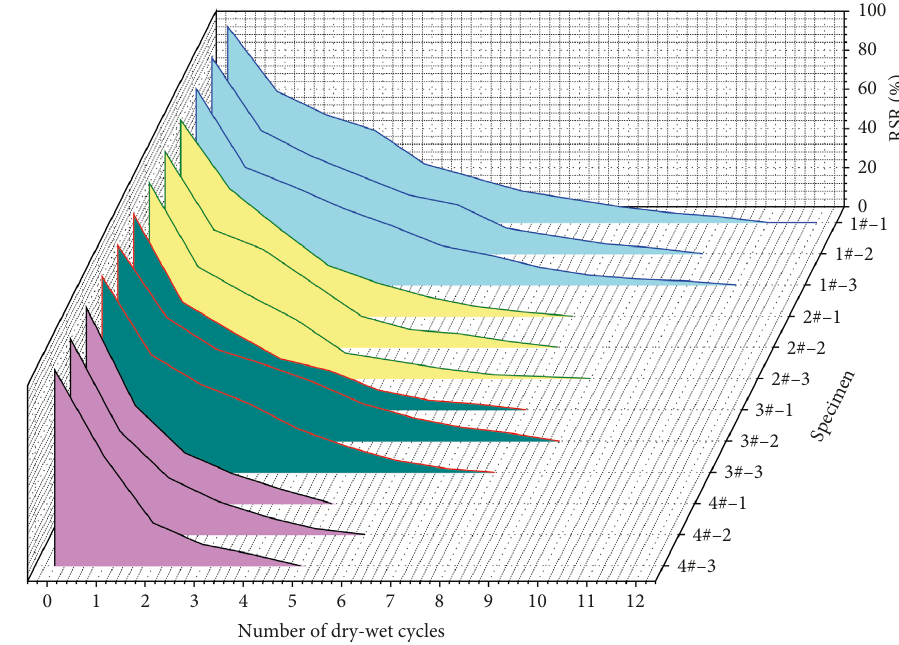
Figure 9: Variation of seepage with dry-wet